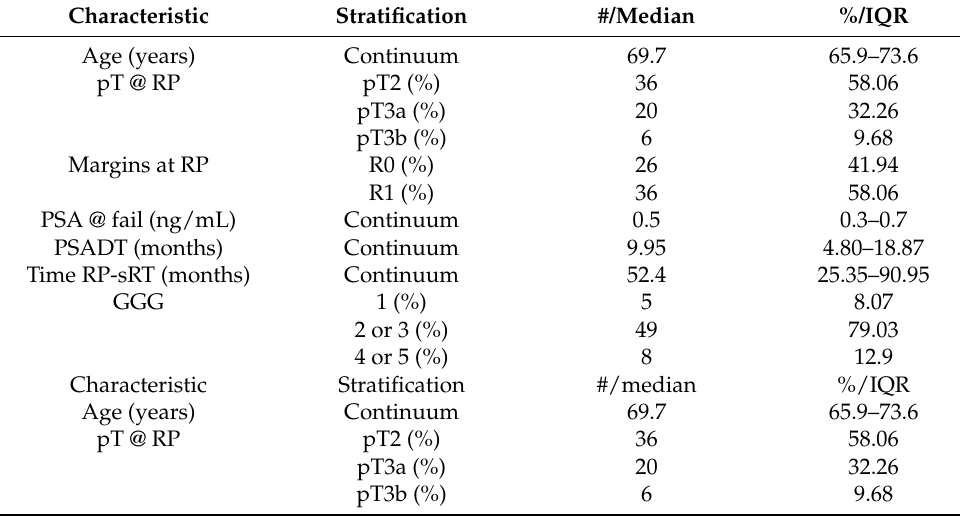
Table 1. Selected patient, tumour, and treatment